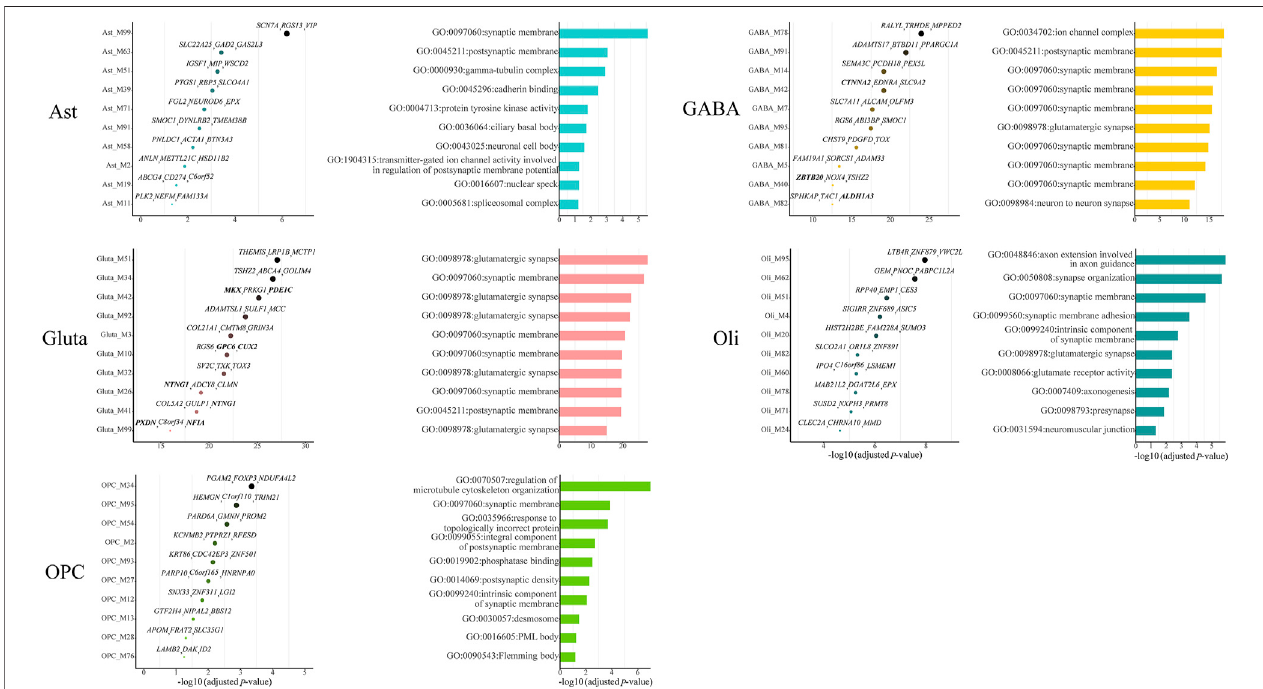
FIGURE 2| Top ten cell-type-speci fi cASD-associated gene modules alongwith their Bonferroni-adjusted hypergeometric test p-values, top three z-score genes, andtoponesigni fi cantGOterm.TheSFARIASDgenesarebold.TheBonferroni-adjustedp-valueswerederivedfromthehypergeometrictestsusingmodulegenesand ASD